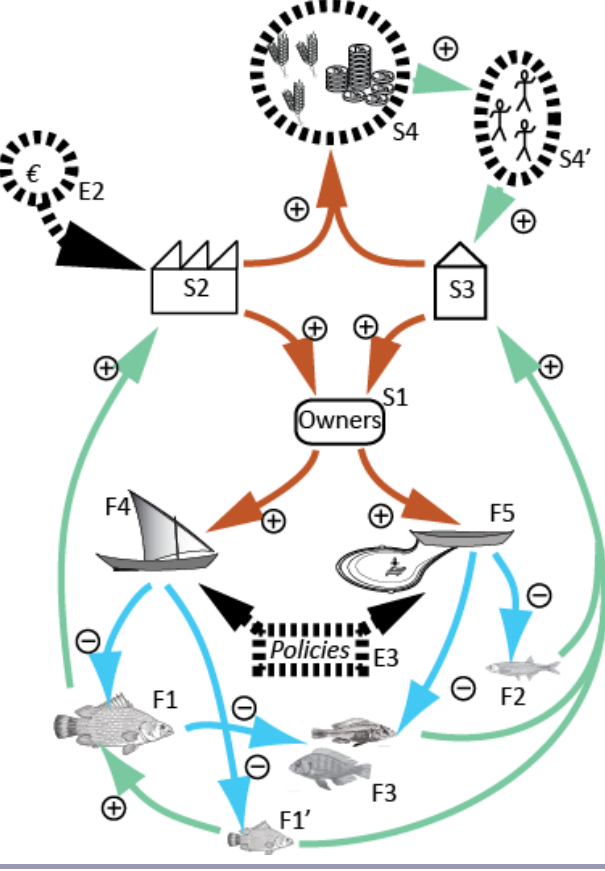
Fig. 2 . Socio-economic interactions. Green arrows represent growth processes (also identified by + sign); blue arrows represent mortality processes (associated with - signs); rust arrows represent investment; thick dotted lines and arrows represent complex systems/interactions not further developed. E2 = international economy; E3 = policies; F1 = large Nile perch; F1' = small Nile perch; F2 = Rastrineobola argentea ; F3 = haplochromines; F4 = Nile perch fishing effort; F5 = R. argentea fishing effort; S1 = boat and camp owners; S2 = international market; S3 = local and regional market; S4 = local and regional economy; S4’ = local